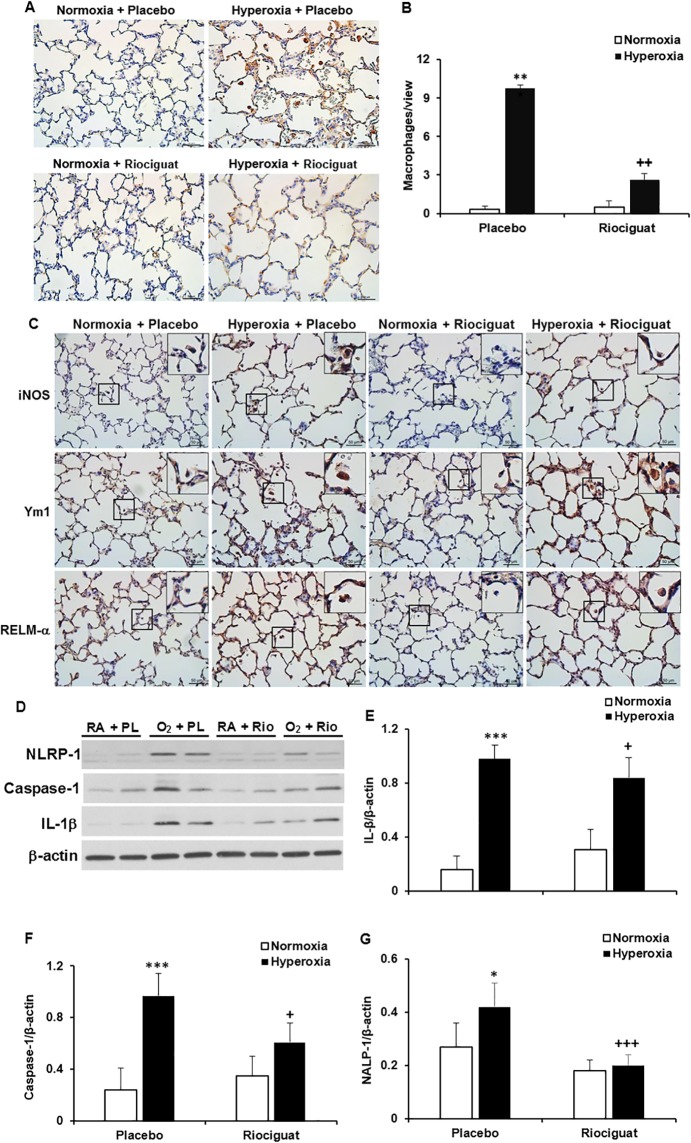
Riociguat reduces and alters hyperoxia-induced lung inflammation.(A) Immunostaining for Mac-3, a macrophage marker. (B) The alveolar airspace macrophage population was increased by hyperoxia exposure as compared to normoxia. Administration of riociguat decreased macrophage count during hyperoxia. ***P < 0.001 compared with normoxia; ++P < 0.01 compared with hyperoxia + placebo (n = 6/group). (C) Immunostaining for the M1 marker, inducible nitric oxide synthase (iNOS), and M2 markers, chitinase 3-like 3 (Ym1) and resistin-like molecule alpha (RELM-α) showed that in hyperoxia plus placebo lungs, both M1 and M2 polarized macrophages were detected. But, treatment with riociguat decreased only M1 macrophages in hyperoxia-exposed lungs. (D) Representative Western blots for NLRP-1, active caspase-1 and active IL-1β. Administration of riociguat decreased hyperoxia-induced lung expression of (E) NLRP-1 (***P < 0.001 compared with normoxia; +P < 0.05 compared with hyperoxia + placebo), (F) active caspase-1 (***P < 0.001 compared with normoxia; ++P < 0.05 compared with hyperoxia + placebo), and (G) active IL-1β (*P < 0.05 compared with normoxia; +++P < 0.001 compared with hyperoxia + placebo). RA: room air, normoxia; O2: hyperoxia; PL: placebo; Rio: riociguat.